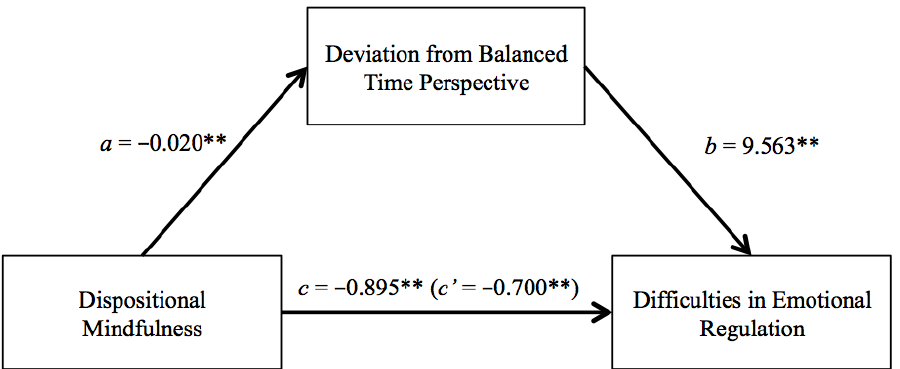
Figure 1. Mediation of time perspective in the relationship between the level of dispositional mindfulness and emotional regulation difficulties. **: p < 0.001